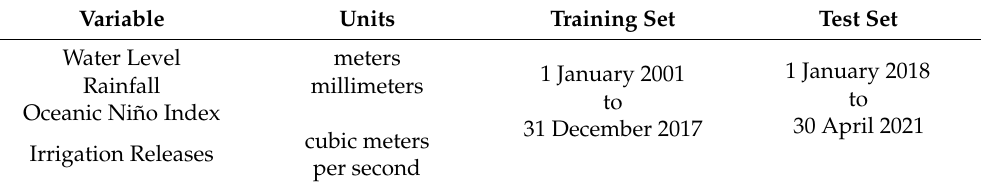
Table 1. List of variables used in this study. All variables have a daily granularity, and the units for each are as indicated.